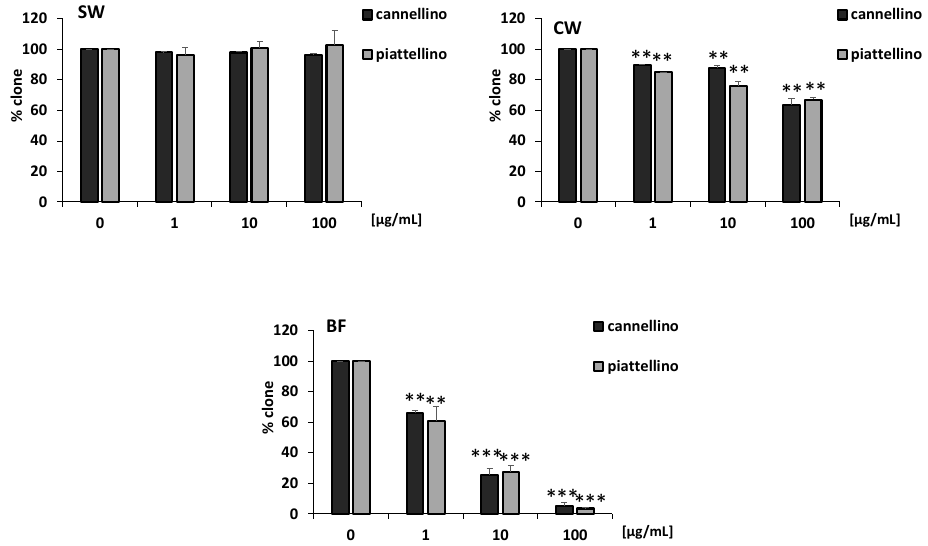
Figure 6. BF reduces HT29 cell clonogenicity. Percentage of colonies of HT29 cells in response to different concentrations (1, 10, and 100 μg/mL) of SW, CW, and BF. Data are expressed as % over basal control and are representative of three independent experiments run in triplicate. Statistical analysis: *** p < 0.001, and ** p < 0.01 vs. basal condition.